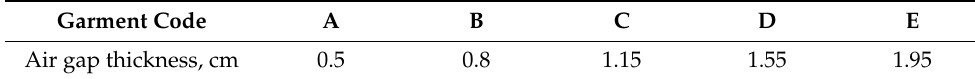
Table 1. Average air gap (ease allowance)